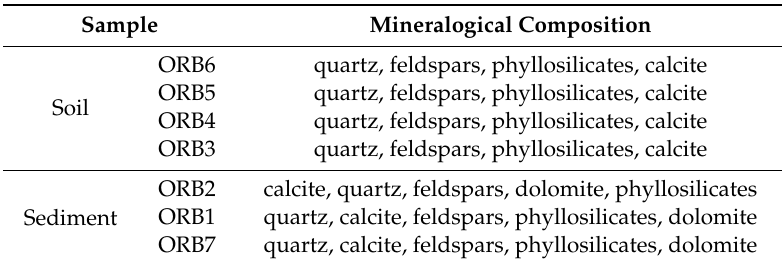
Table 1. Mineralogical composition for the studied